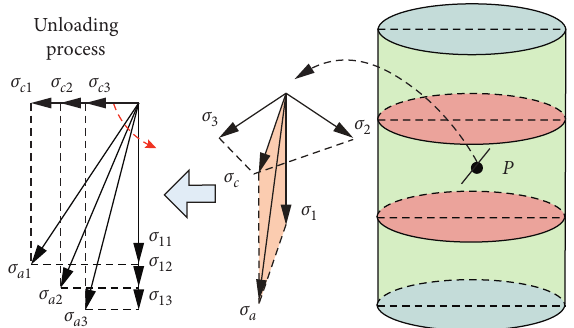
Figure 6: Trend of stress in coal during the